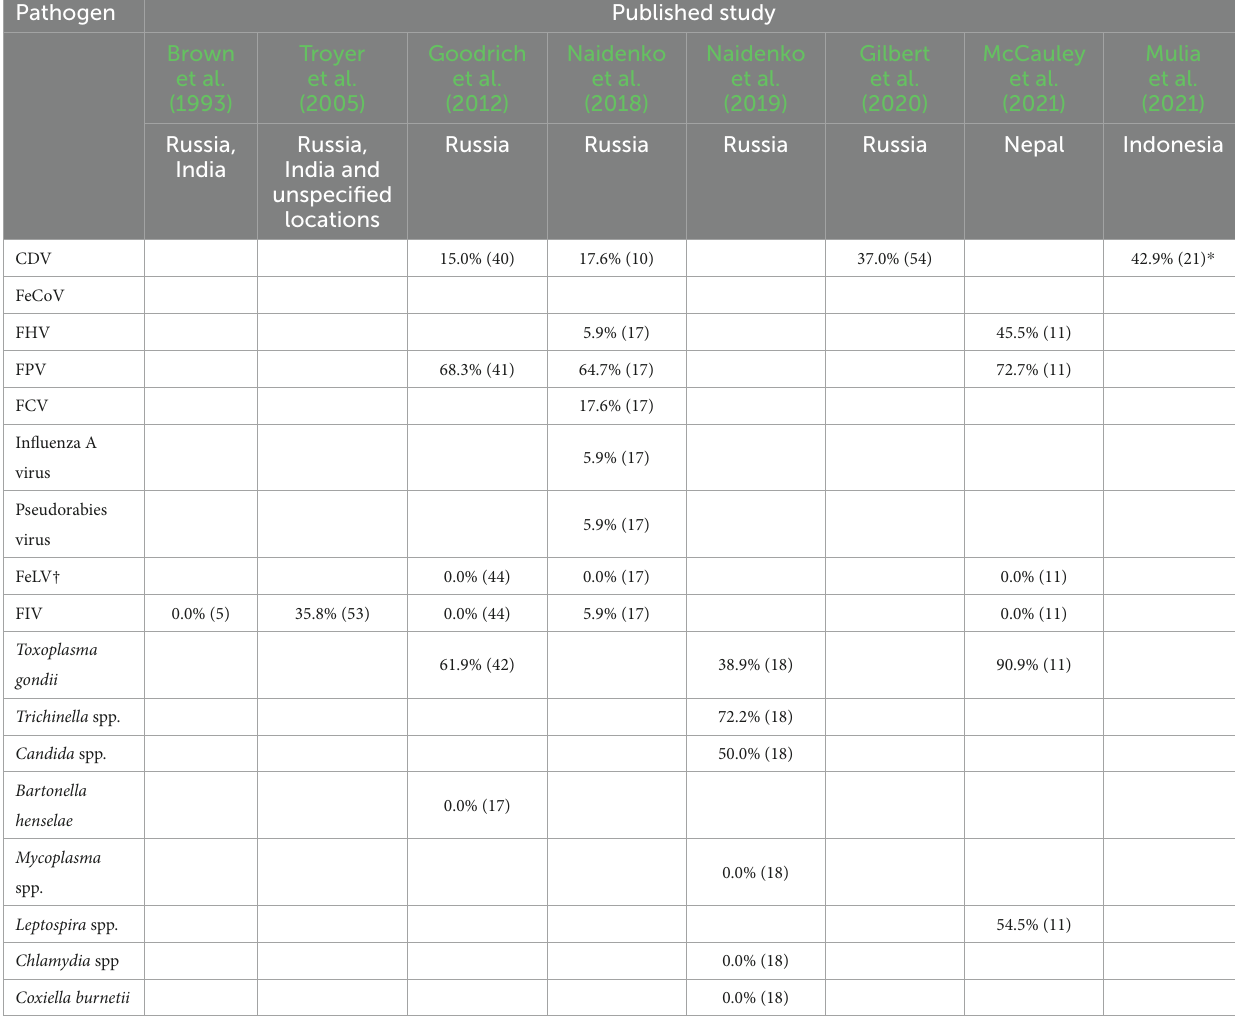
TABLE 1 Summary of published serological survey findings of free-ranging tigers, indicating location of sample